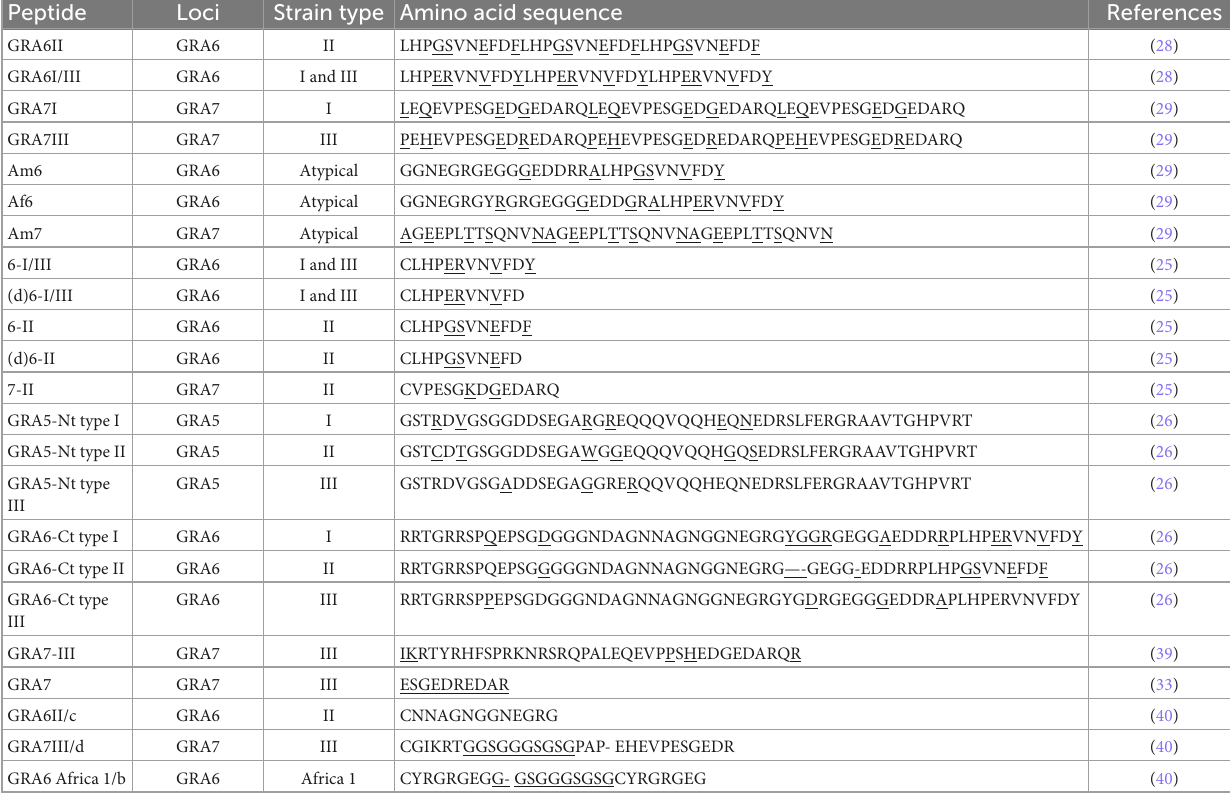
TABLE 3 Amino acid sequence of GRA5, GRA6, and GRA7 synthetic peptides that better discriminate the different serotypes. Peptide Loci Strain type Amino acid sequence